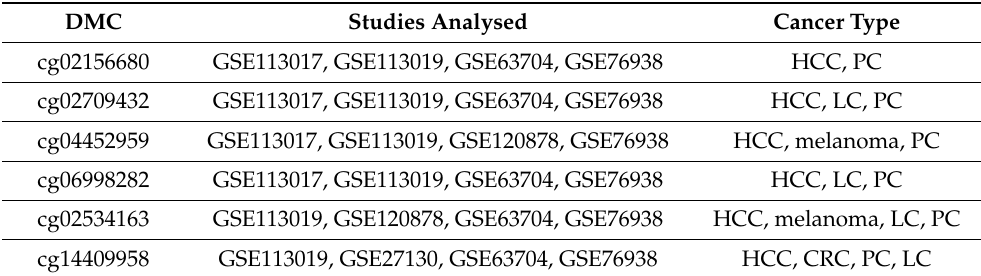
Table 3. Common DMCs across different cancer types, located at TSS or 1st exon, all presenting upregulation of methylation in relation to respective benign controls.